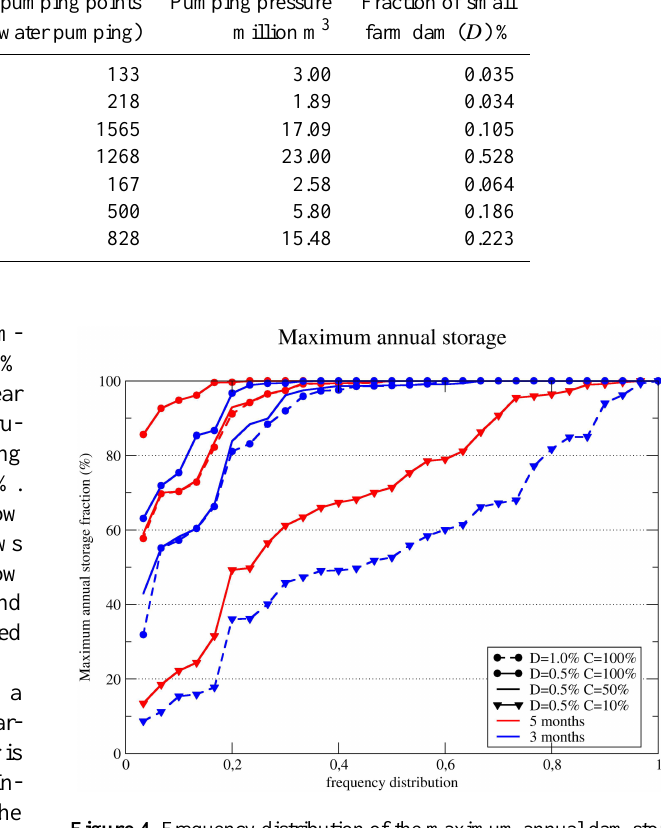
Figure 4. Frequency distribution of the maximum annual dam stor- age expressed as a fraction of the maximum capacity according to the filling period (3 or 5 months), the spatial extent of the dams ( D =1 or 0.5%) and the size of the catchments ( C =10, 50 or